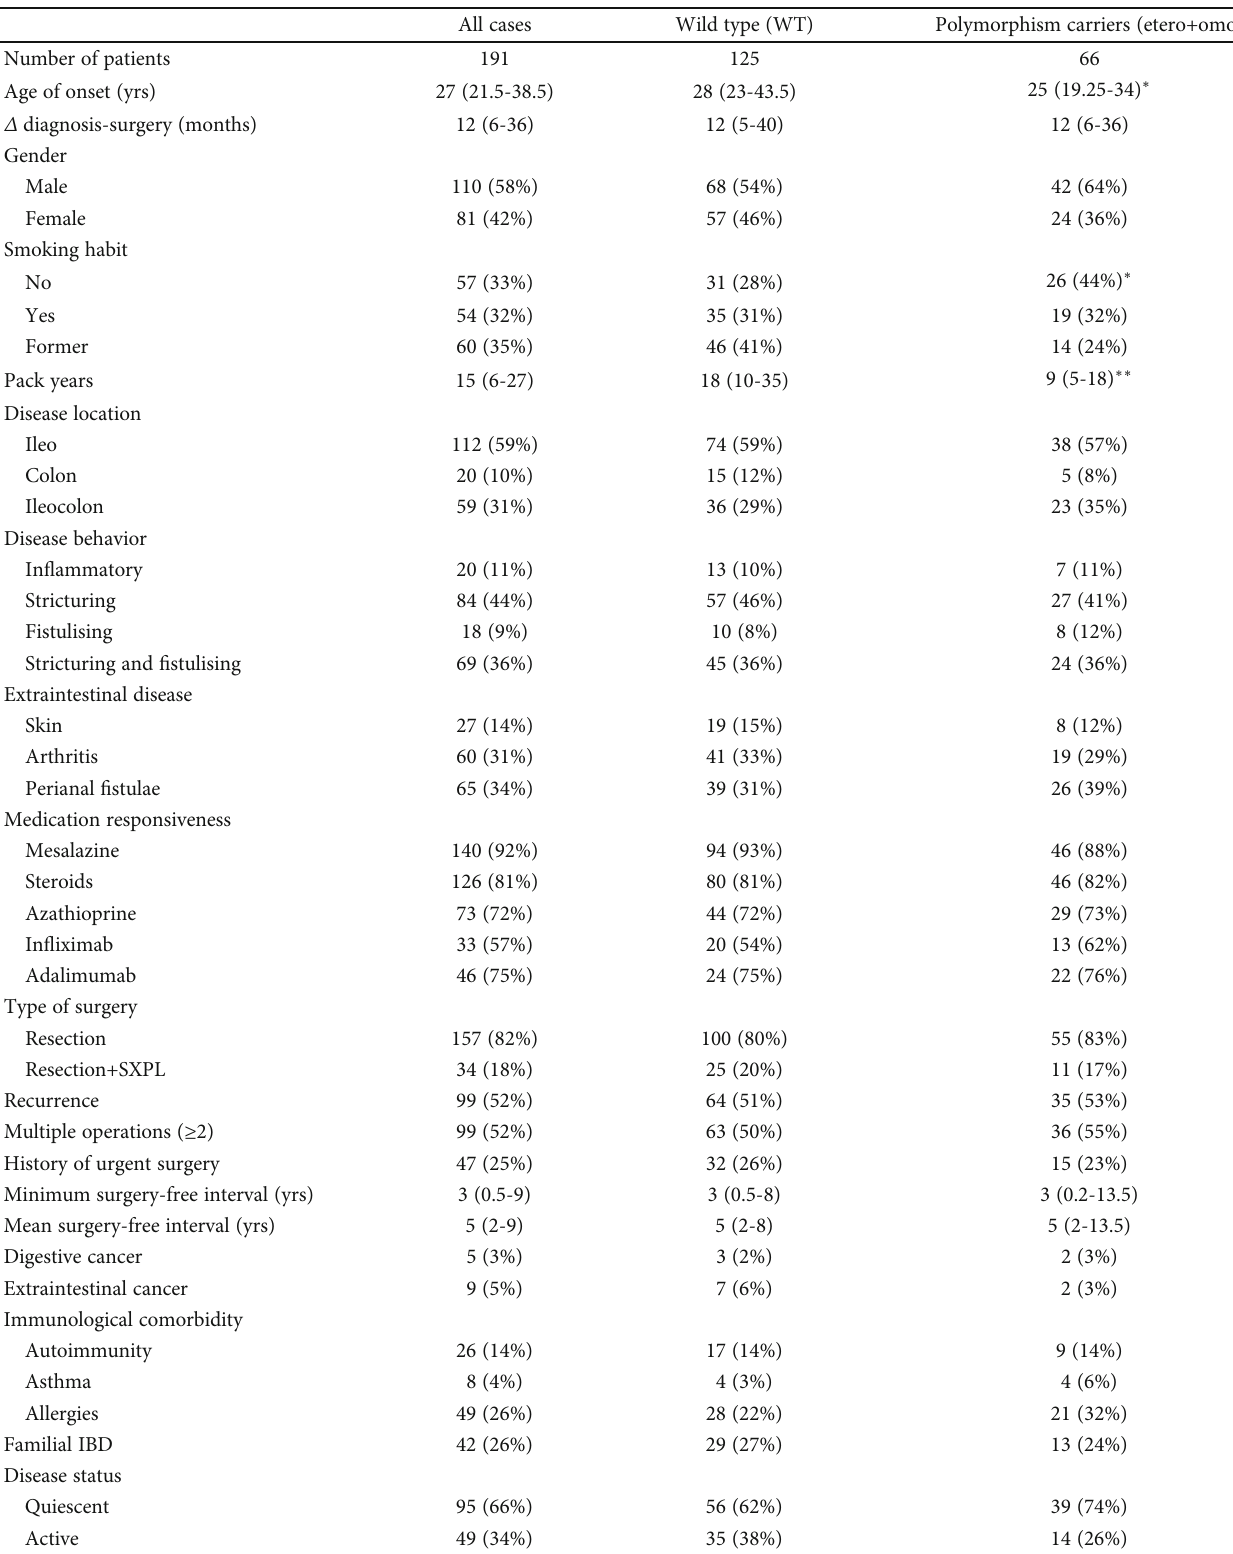
Table 1: Demographic and clinical features of CD